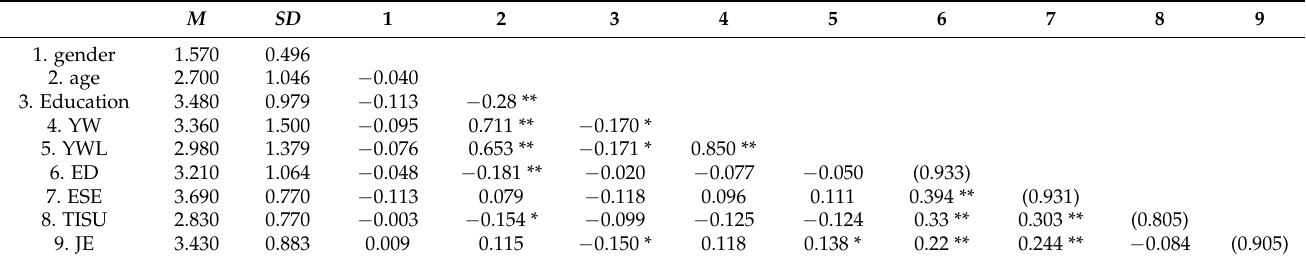
Table 6. Descriptive statistical results and correlation coefficients of variables.